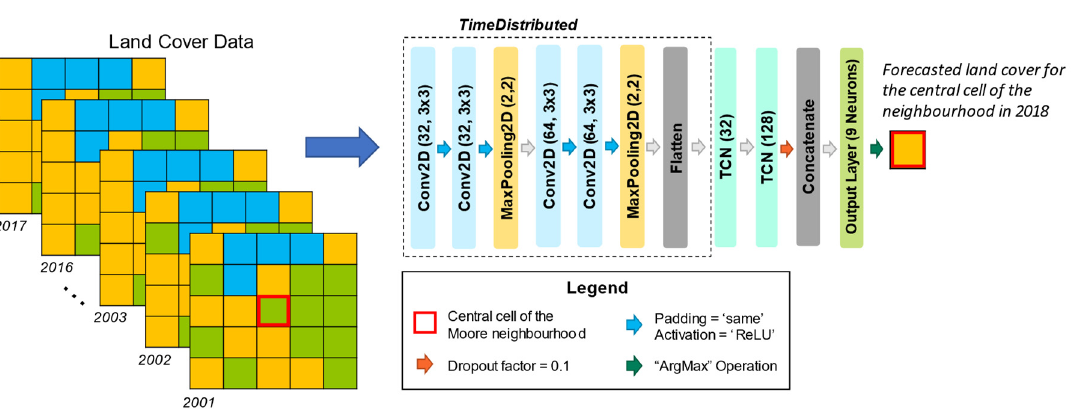
Figure 3. Configuration for training a single-branch CNN–TCN model accepting LC data sequences with a 5 × 5 Moore neighborhood.